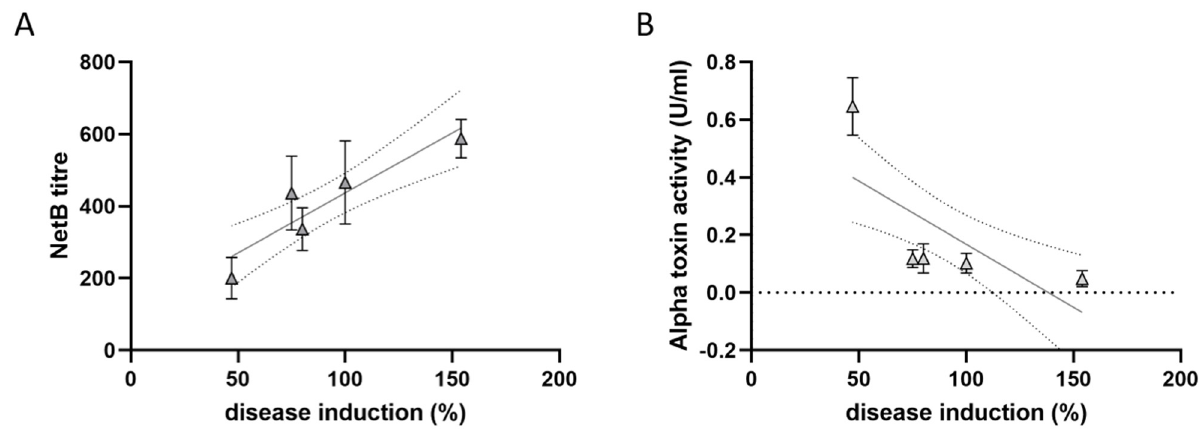
Figure 6. Correlation between the in vitro NetB ( A ) or alpha toxin ( B ) production and the virulence of the C. perfringens strains in an NE in vivo model. All strains were grown in TGY medium for 24 h, after which both the NetB titre (supernatant dilution that induces 50% of haemolysis) and alpha toxin activity in the supernatant was determined. The virulence of the strains was previously assessed by Keyburn et al. and is expressed as % disease induction in the NE in vivo model, relative to the virulence of strain NE18 [23]. Each triangle represents the mean ± standard deviation of triplicate experiments. The linear regression line, together with its 95% confidence interval, are plotted in grey.